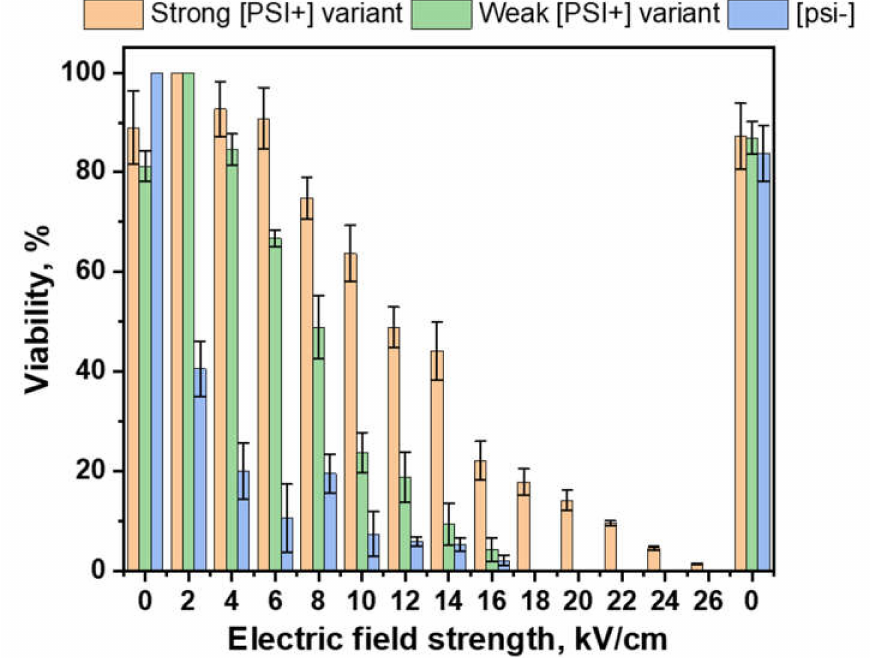
Figure 3. Viability (%) of the S. cerevisiae cells after exposure to a pulsed electric field (PEF) with different strength of electric field (kV/cm), 1 ms pulse duration, 5 pulses. Orange bars represent the viability of S. cerevisiae with a strong [PSI+] variant; green bars represent the viability of S. cerevisiae with a weak [PSI+] variant; blue bars represent the viability of S. cerevisiae without [PSI+]. Data presented as average ±